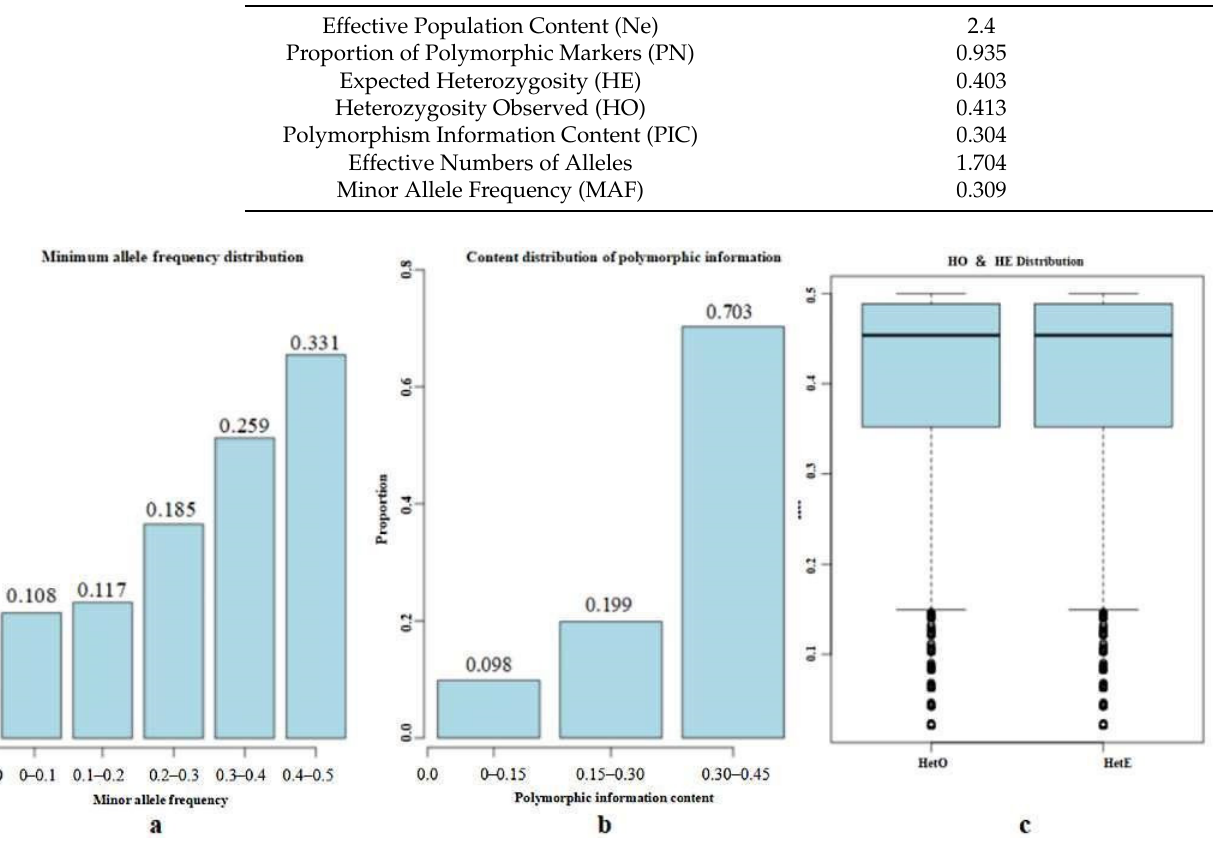
Figure 3. Genetic Diversity Analysis results. Note: ( a ). Minimum allele frequency distribution (the abscissa indicates the minimum allele frequency interval, and the ordinate indicates the SNP proportion). ( b ). Distribution of the Polymorphism Information Content (the abscissa represents the PIC interval value, and the ordinate represents the SNP proportion). ( c ). Heterozygosity analysis (Note: the abscissa indicates the classification of Ho and He, and the ordinate indicates the heterozygosity value).